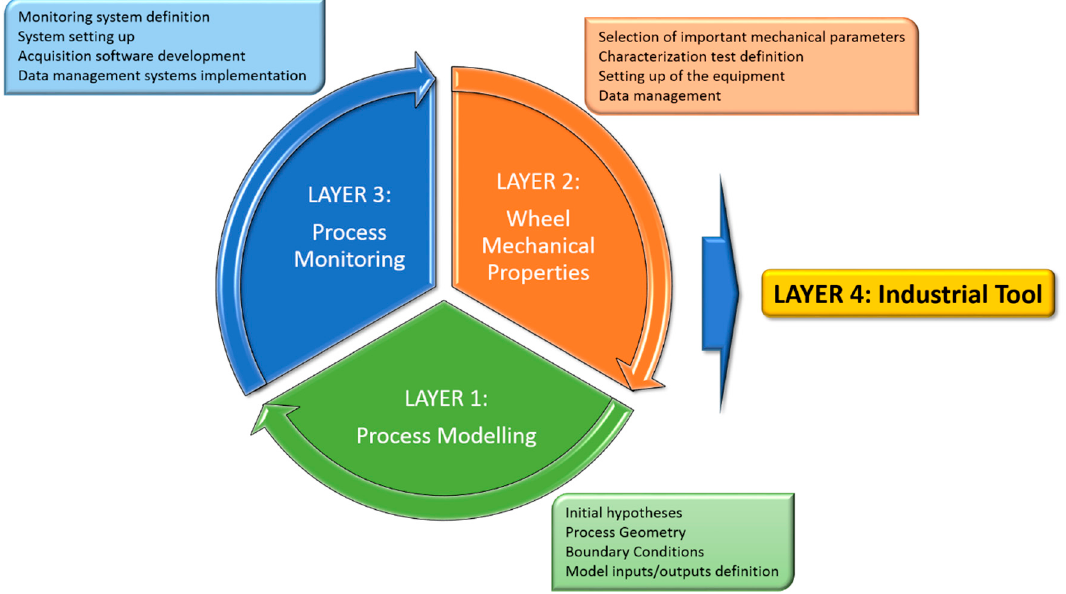
Figure 1. Structure and interaction between layers in the digital twin (DT) for the grinding industry.